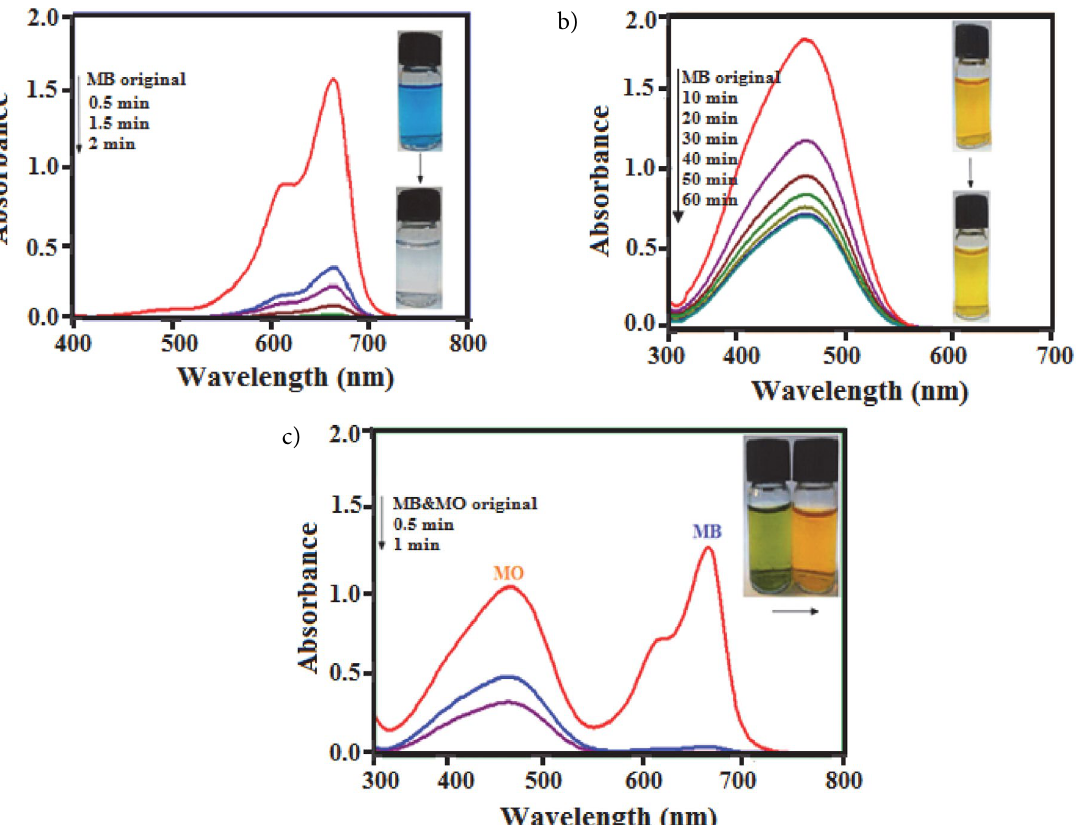
Figure 10. The adsorption capacity of Ag/CuFe 2 O 4 /rGO toward different organic dyes: (a) MB, (b) MO and (c) mixed dyes (MB + MO). Experimen- tal conditions: dosage of adsorbent = 50 mg, [dye] = 25 mg/L, temperature = 25 °C and